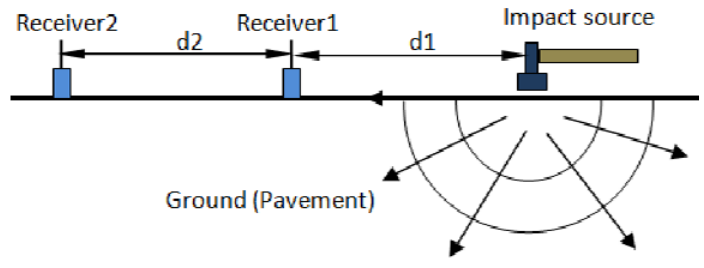
Figure 1. Test configuration of SASW